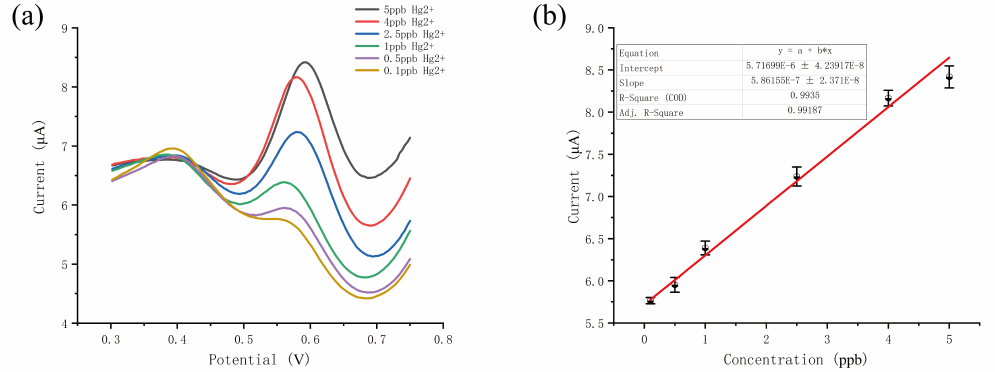
Figure 5. ( a ) current response of different Hg 2 + concentrations; ( b ) liner response curve to Hg 2 + .